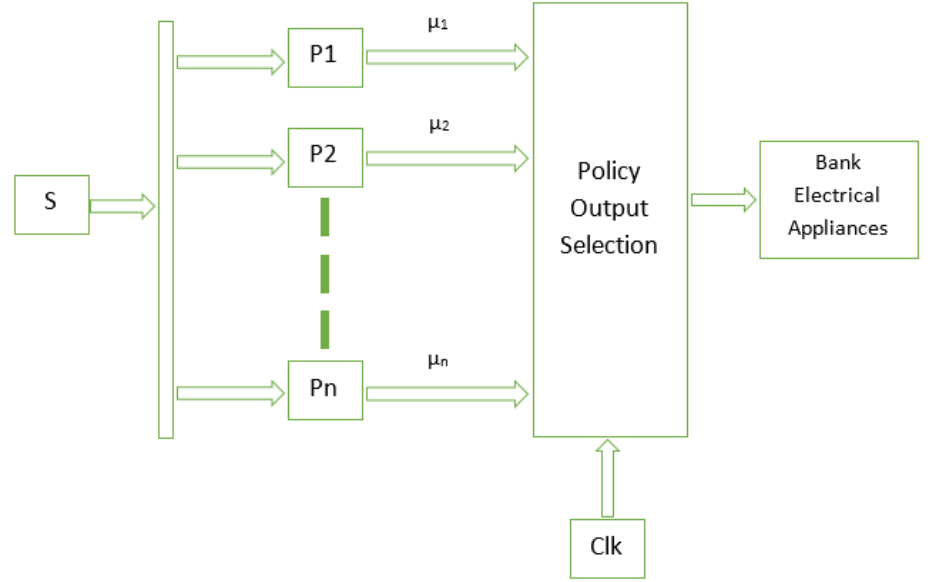
Figure 3. Policy selection decomposed model .